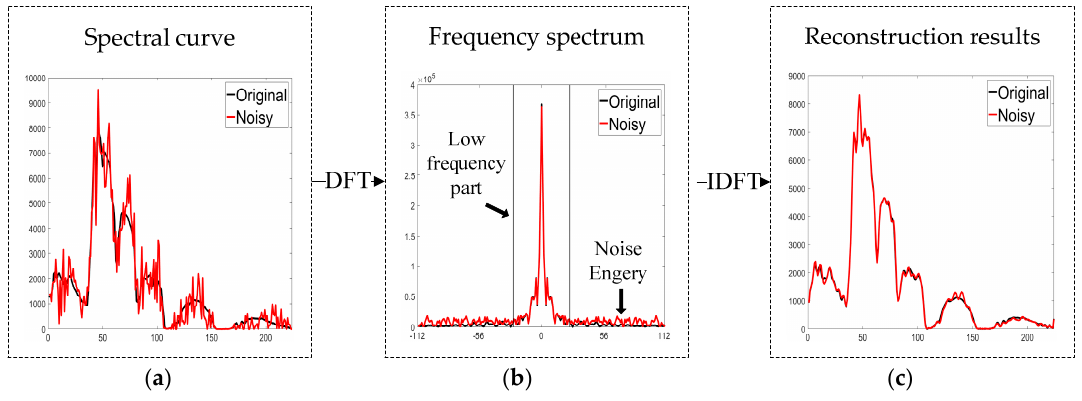
Figure 1. Illustration of the frequency spectrum transformation and its reconstruction under noise corruption. ( a ) The original and noisy spectral curves; ( b ) the frequency transformation results of the original and noisy spectral signatures; ( c ) the reconstruction results of the original and noisy spectra.